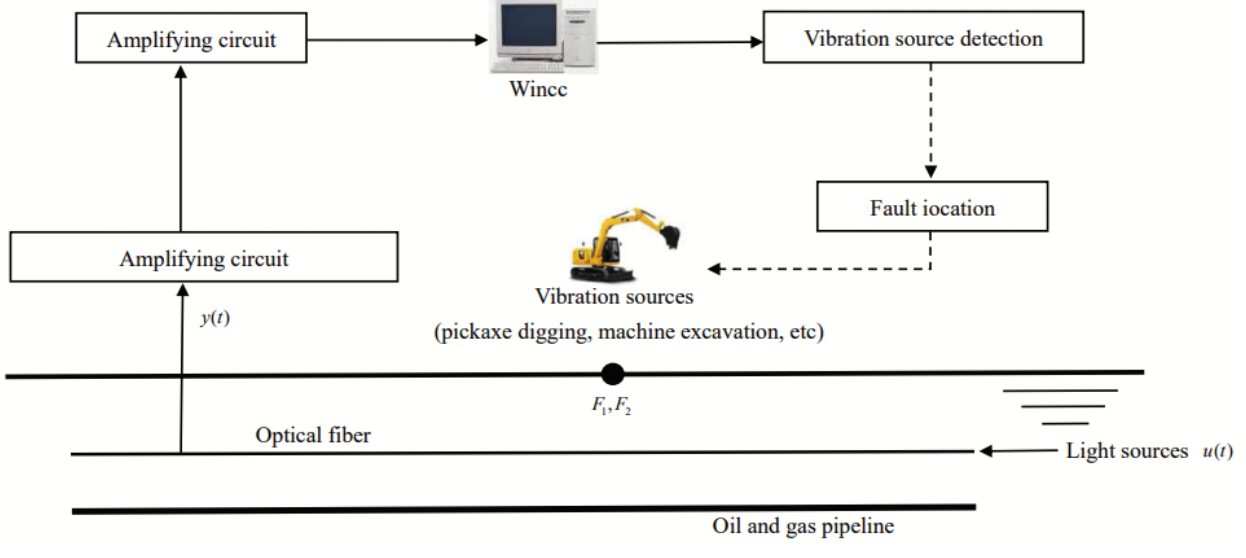
Figure 1. Fiber vibration source detection